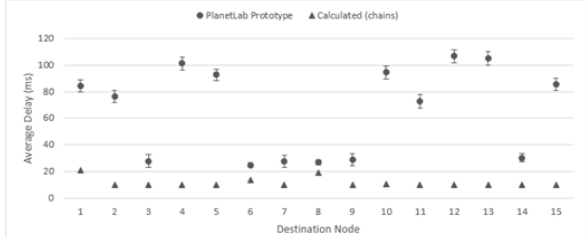
Fig. 12. Average Delay for Multicast Network with 40 Nodes and 20 Destinations